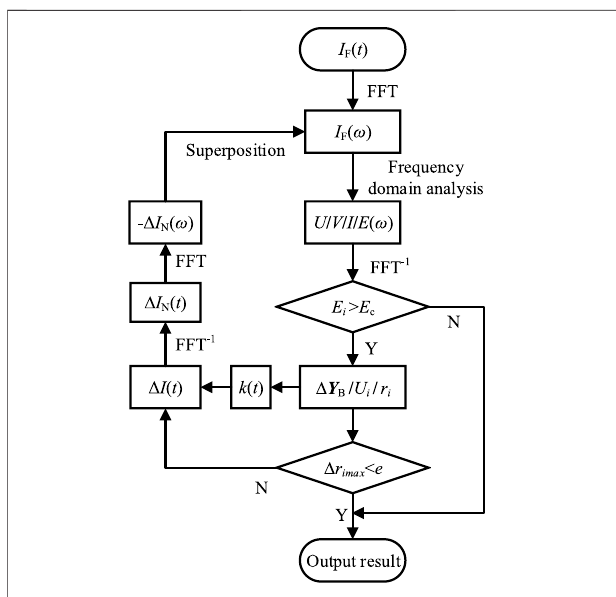
FIGURE 3 | Equivalent radius iterative algorithm fl ow